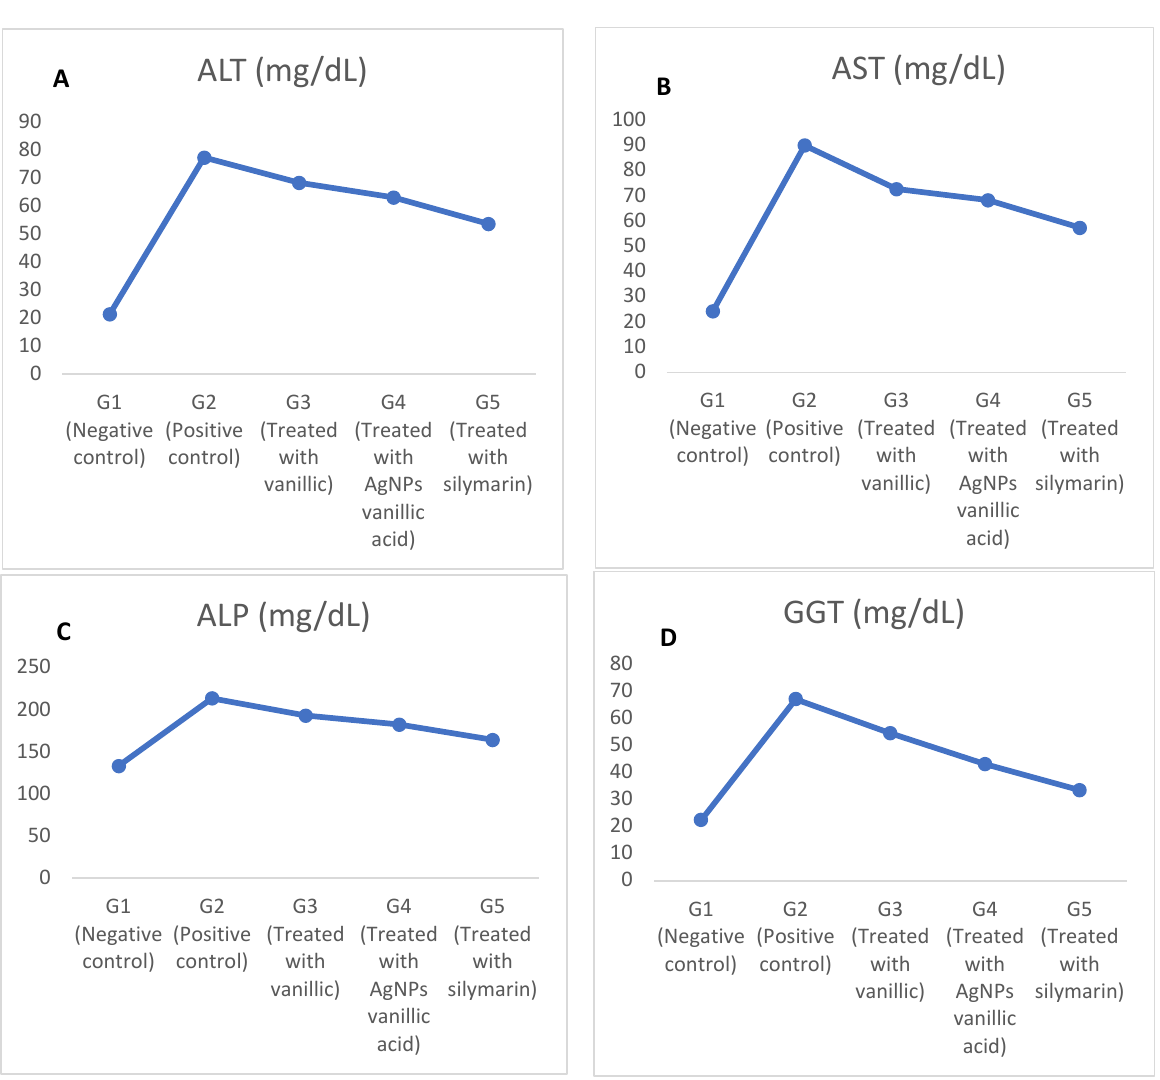
Figure 4. The effects of vanillic acid-loaded silver nanoparticles on serum liver enzymes in CCl 4 liver toxicity-induced rats. ( A ): ALT, ( B ): AST, ( C ): ALP, and ( D ): GGT.